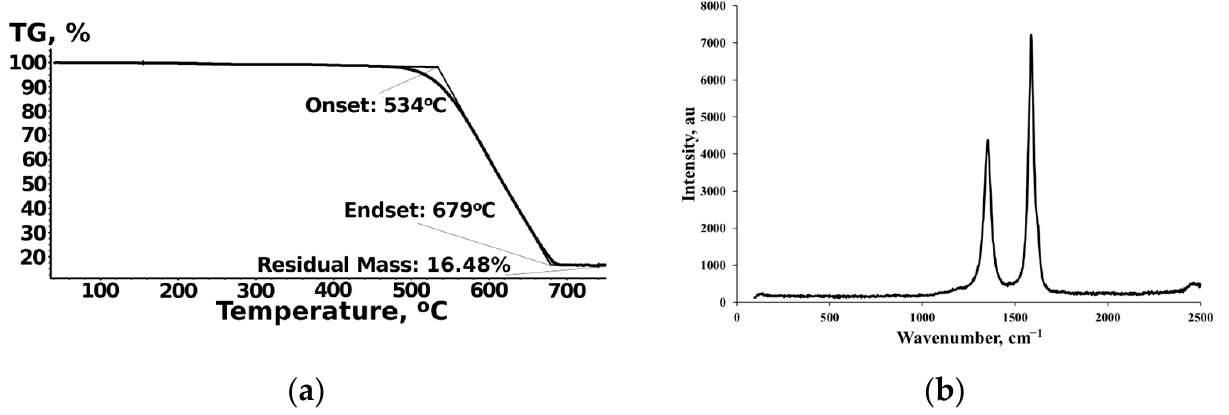
Figure 1. Thermogravimetry curve ( a ) and Raman spectrum ( b ) of initial CNTs synthesis products.